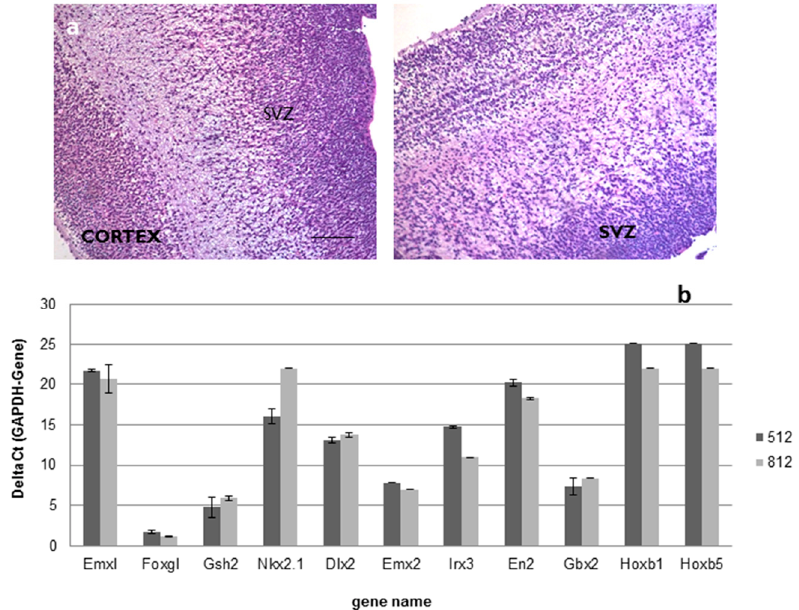
Figure 1. ( a , b ). Positional identity: ematoxylin and eosin staining followed by histological examination confirmed the subventricular origin of brain sample used as raw material in the hNSCs production (Scale bar: 100 µm) ( a ); real-time PCR analysis confirmed that all the samples used in the production belonged to the forebrain ( b ) .